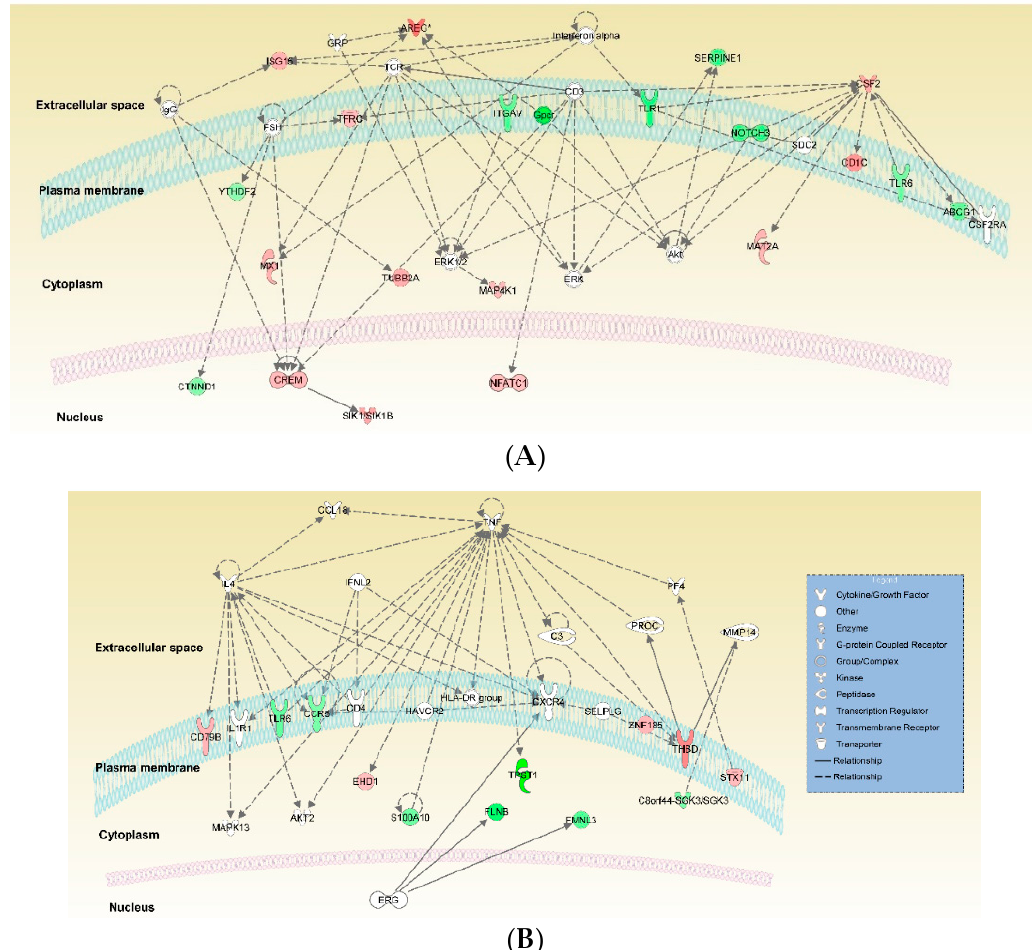
A total of 8 related networks were found under the IPA network based on functional annotations. The network with the highest score (score of 36) consisting of 20 focus molecules was associated with cell death / survival, cancer, and organismal injury / abnormality (Figure 2A). Extracellular signal-regulated kinase (ERK) 1 / 2 and protein kinase B (Akt) were the key nodes of this network. Other genes, such as amphiregulin ( AREG ), colony-stimulating factor 2 ( CSF2 ), and the cluster of di ff erentiation 1 ( CD1c ), were also involved in this network. The second-ranking network with a score of 18 included 12 focus molecules associated with cardiovascular system development / function, cell-to-cell signaling / interaction, and cellular movement (Figure 2B). The second network was composed of cytokines, chemokine receptors, and transmembrane receptors. Of the 11 DEGs identified, tyrosylprotein sulfotransferase 1 ( TPST1 ), filamin B ( FLNB ) and thrombomodulin ( THBD ) were in the second network.